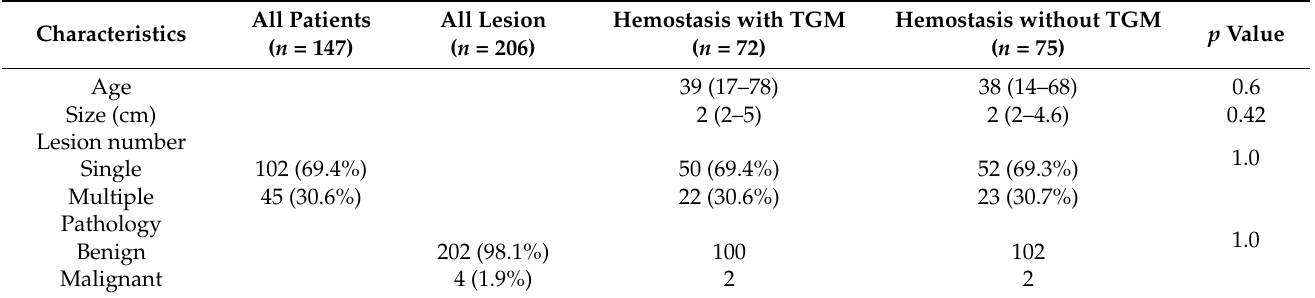
Table 1. Patient demographics and lesion